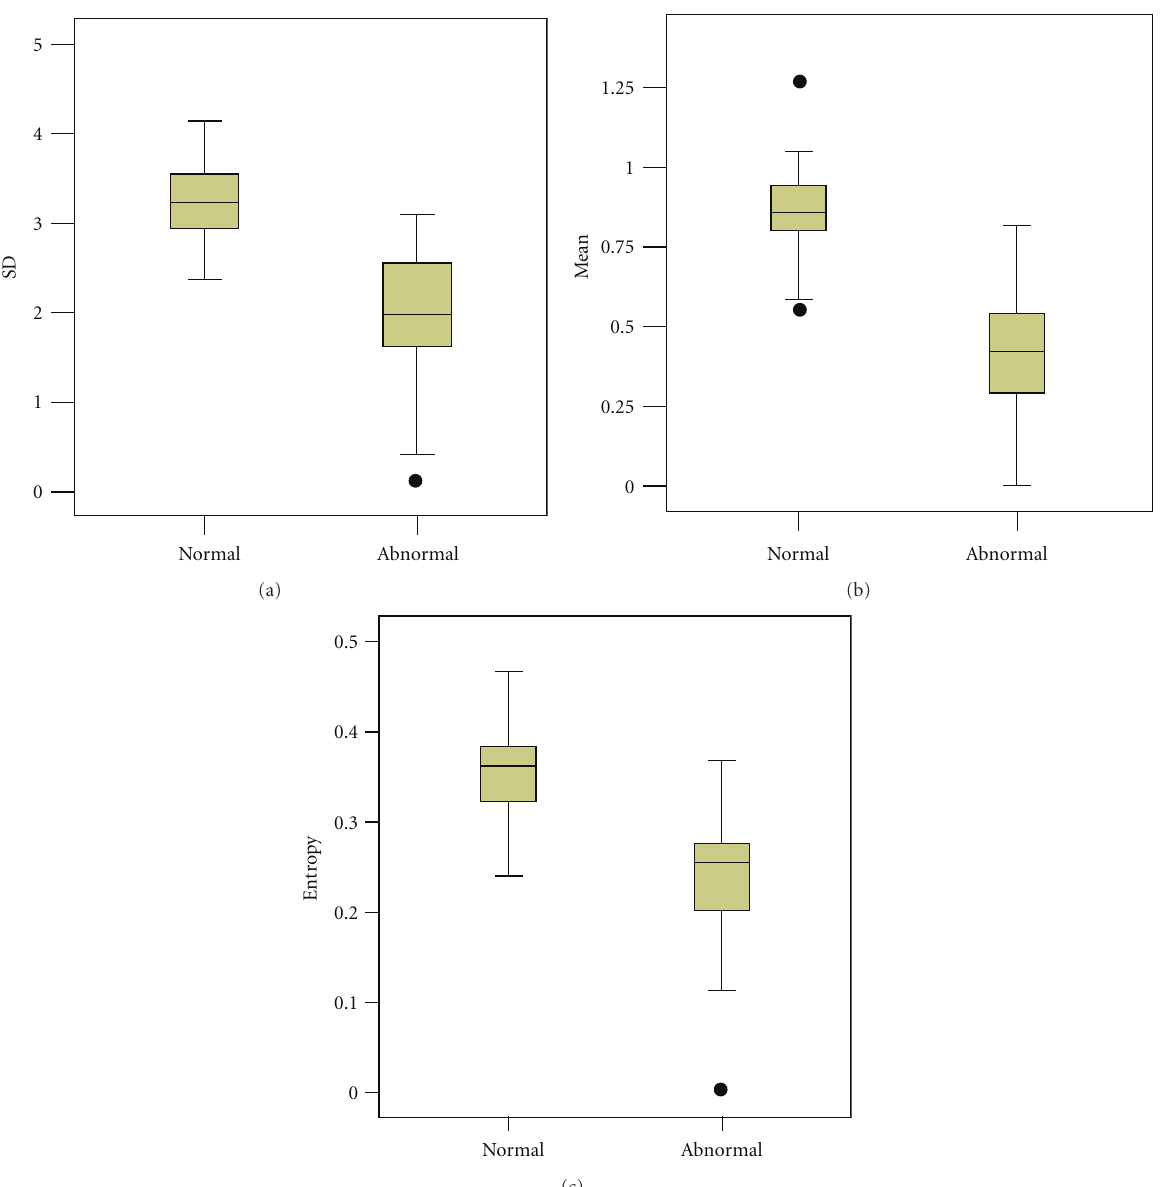
Figure 2: Boxplots of normal and abnormal groups SD, mean, entropy, and body weight compared with reference line.